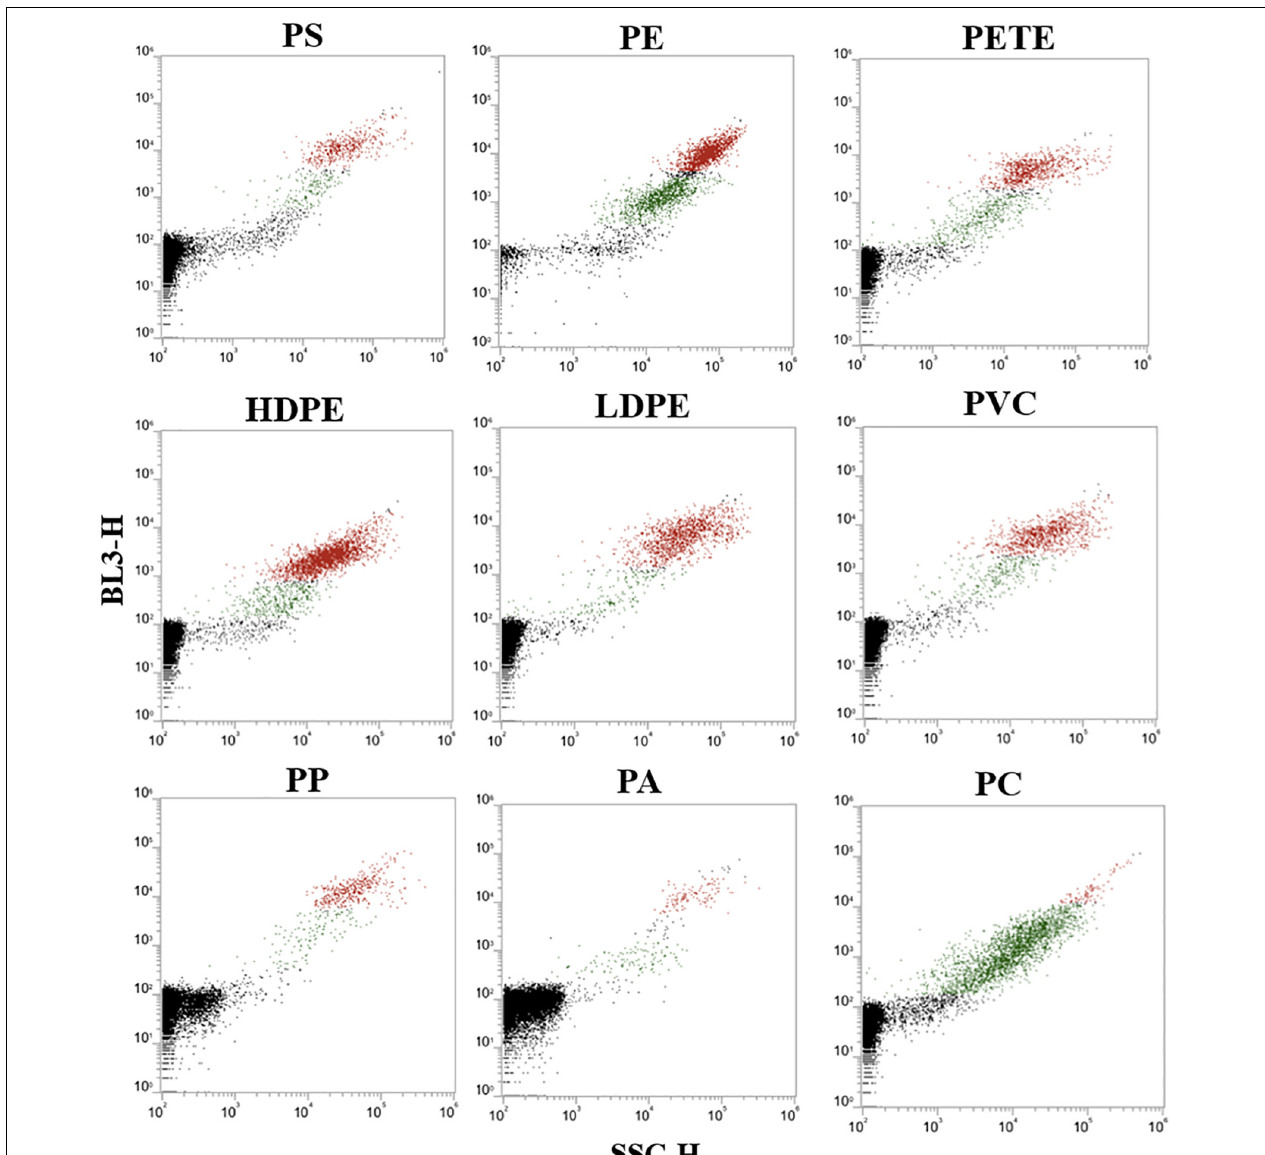
FIGURE 6 | Initial dot plot screen (red fluorescence v/s side scatter) for all the nine plastic types stained with NR, along with the dot plots for NR (without microplastics). The plastic types analyzed were polystyrene (PS), polyethylene (PE), polyethylene terephthalate (PETE), high density polyethylene (HDPE), low density polyethylene (LDPE), polyvinyl chloride (PVC), polypropylene (PP), nylon (PA), polycarbonate (PC). The black coloration shows the background noise, green and red coloration represents the stained plastic particles and aggregated NR,